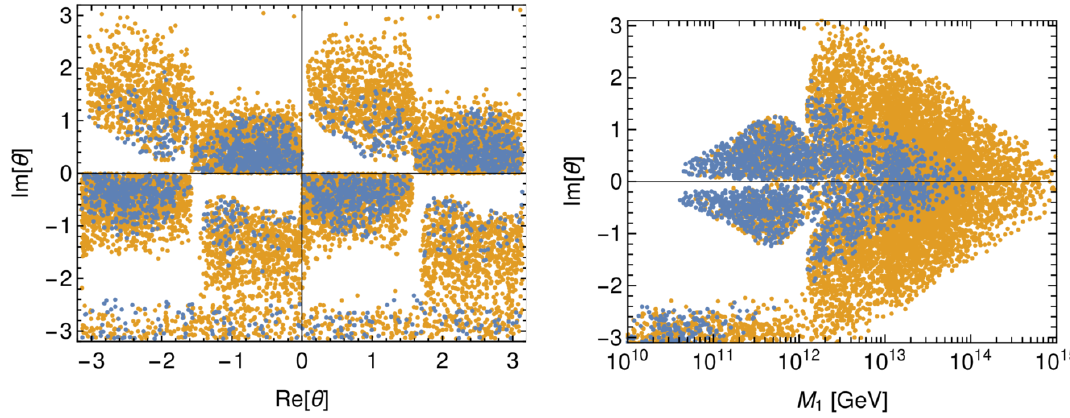
Figure 2 . The colouring of the points is the same as in (cid:12)gure 1. We display the dependence on the real and imaginary part of the complex angle that enters in the R